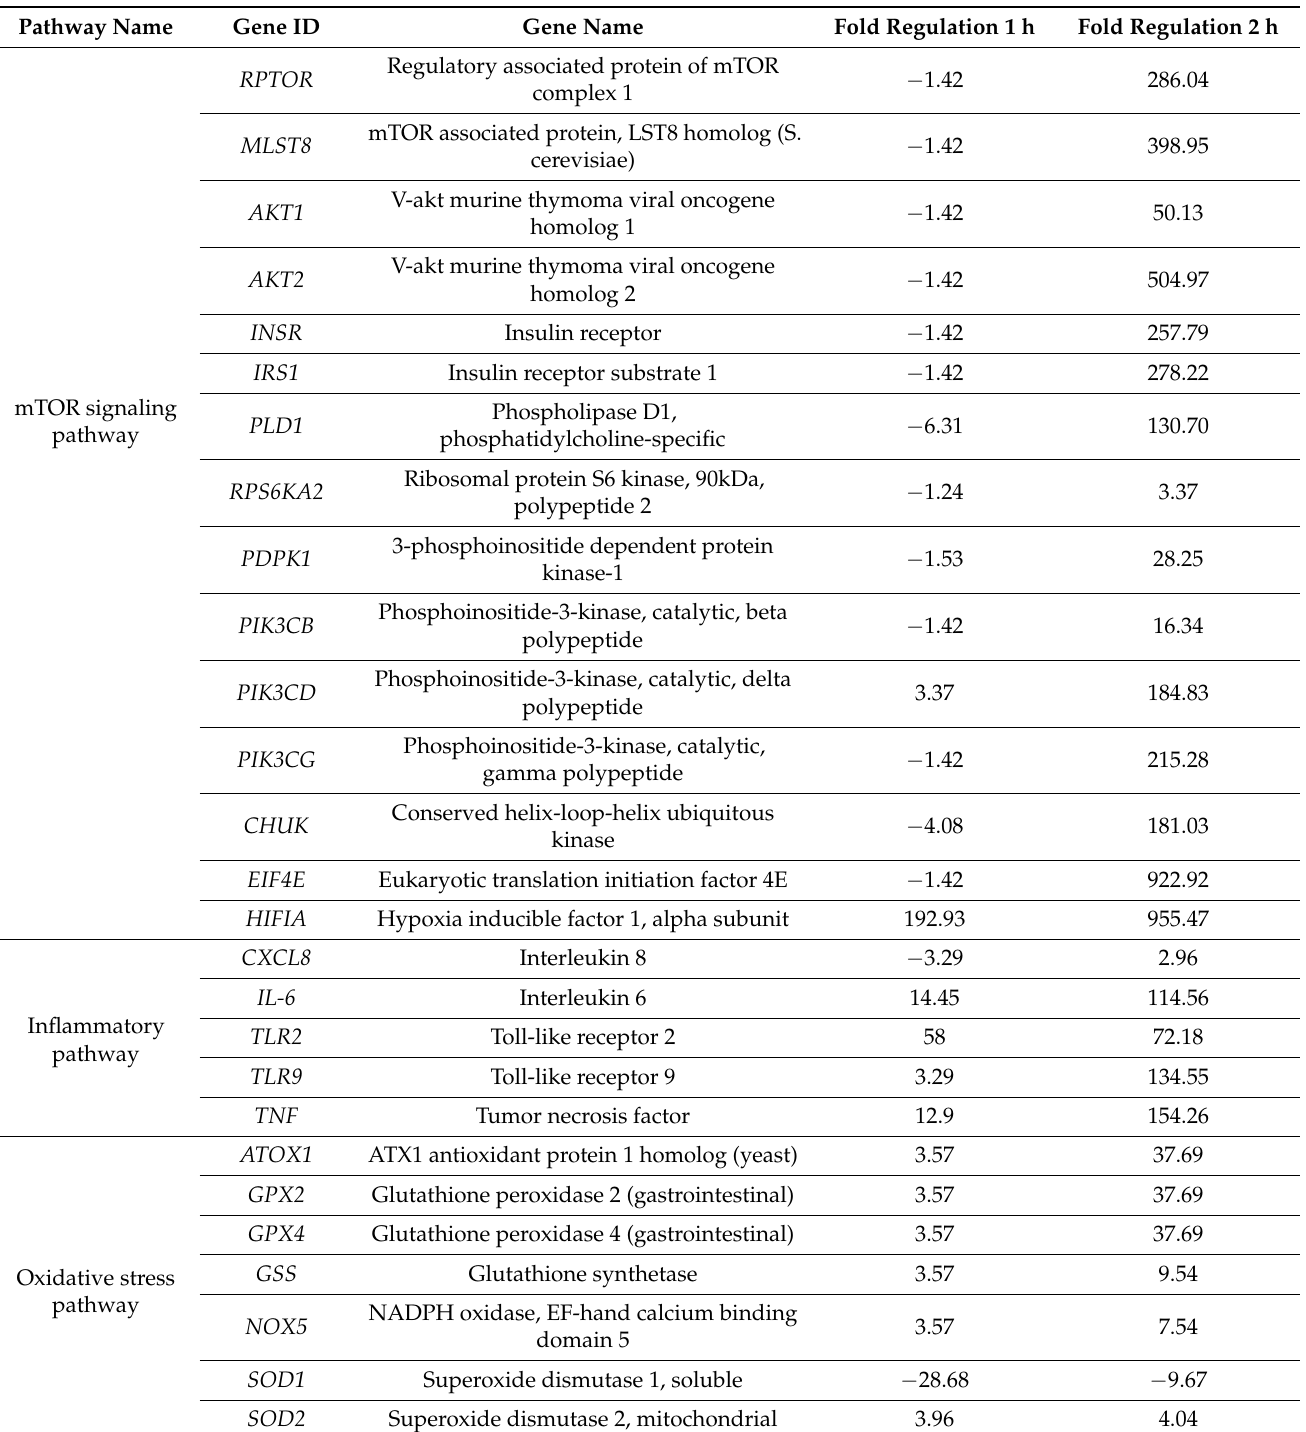
Table 2. Genes of mammalian Target of Rapamycin (mTOR) signaling, inflammatory, and oxidative stress pathways detected by polymerase chain reaction (PCR) array technology and differently expressed in MKN-28 cells incubated with Hpcf for 1 or 2 h. Variation of gene expression levels is reported as fold regulation. Values > |2| are considered statistically significant (Reprinted with permission from ref. [14]. Copyright 2021, Domenico